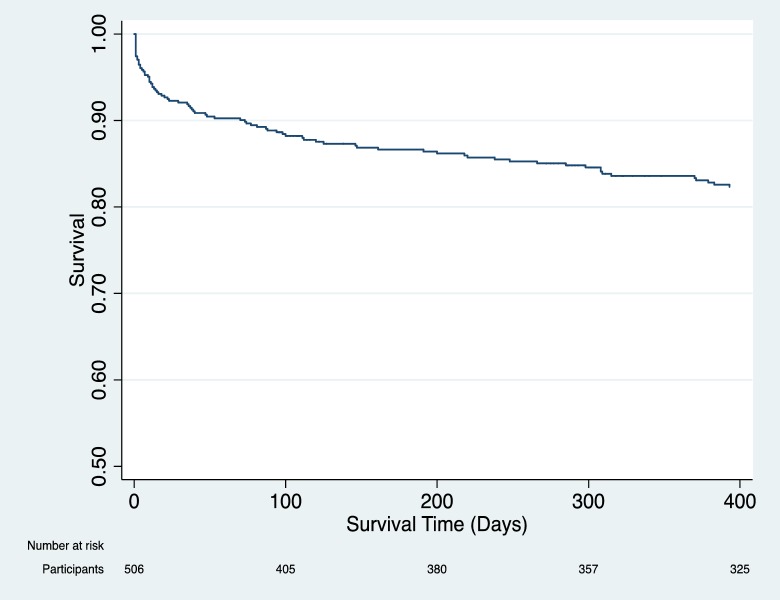
Survival curve for all participants.